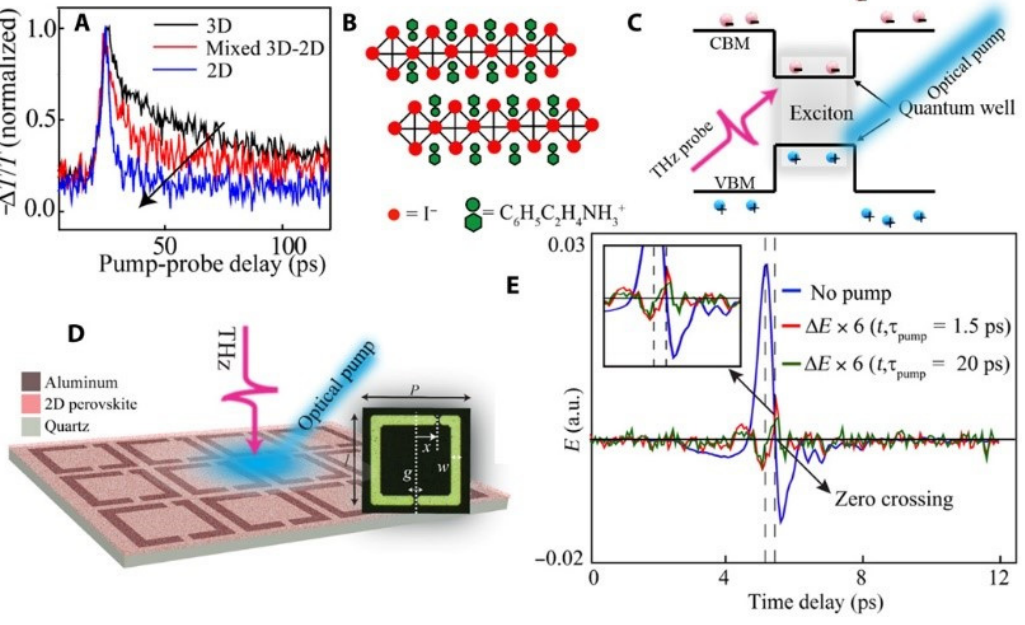
Figure 12. Two-dimensional perovskite ultrafast measurement of. ( A ) Three-dimensional perovskite (black solid curve), mixed 3D–2D perovskite (red solid curve), and pure 2D perovskite (blue solid curve) thin films free carrier excitation and relaxation dynamics. Using a 400 nm pump beam at 750 μ J/cm 2 , thin films are photoexcited. ( B ) Two-dimensional perovskite crystal structure’s schematic that makes QWs. ( C ) Scheme of the quantum confining of the pure 2D perovskite in the QW structure ( D ) The artistical example of the perovskite-coated hybrid metadevice with spin-coated 2D perovskite (thickness 60 nm) on top of TASR and photo-excited with a 400 THz optical pump beam. ( E ) THz electric field transmission (blue solid line) and THz photomodulation pulse Δ E(t) at τ pump = 1.5 ps (red solid curve) and 20 ps (green solid line) measured in the 2D perovskite thin film (Reprinted with permission from Creative Commons Attribution-Non Commercial License 4.0 (CC BY-NC)).